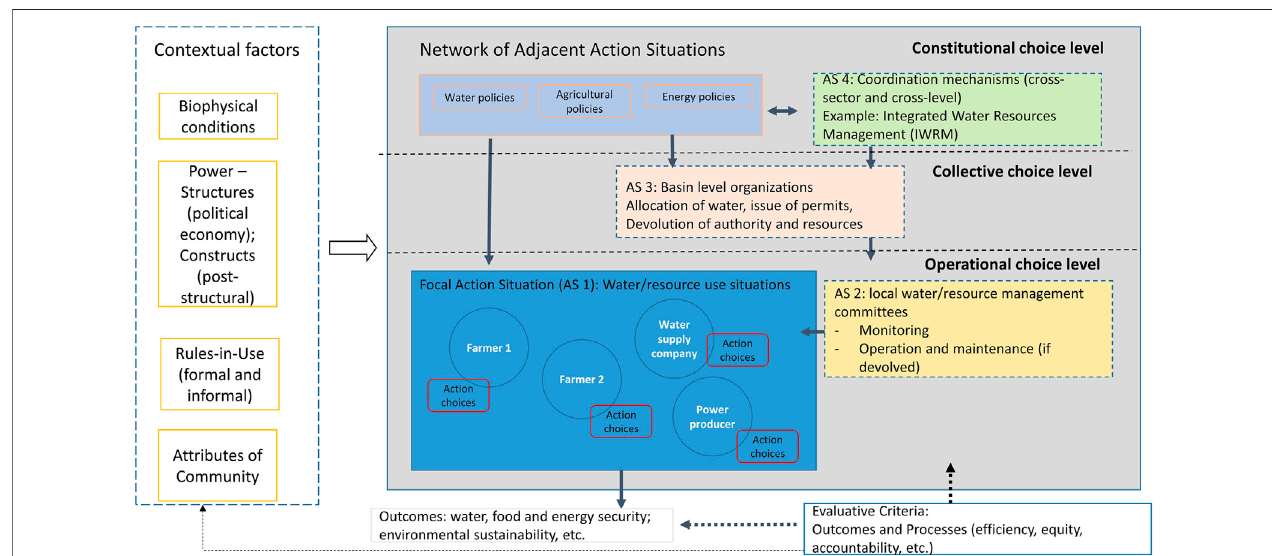
FIGURE 2 | Networks of adjacent action situations in provision of water, energy and food (WEF) securities. Source: Authors (based on Ostrom, 1990; Clement, 2010; McGinnis, 2011).